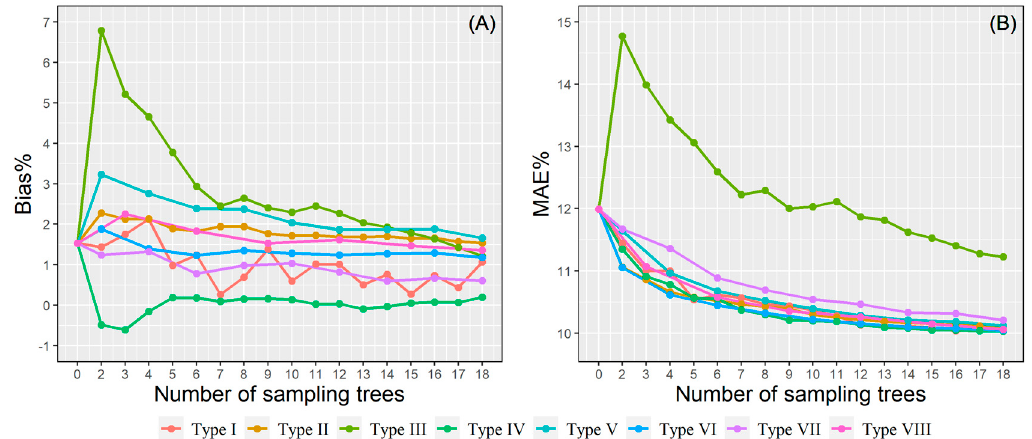
Figure 7. The bias% ( A ) and MAE% ( B ) of the eight sampling strategies using the plot-level calibration.